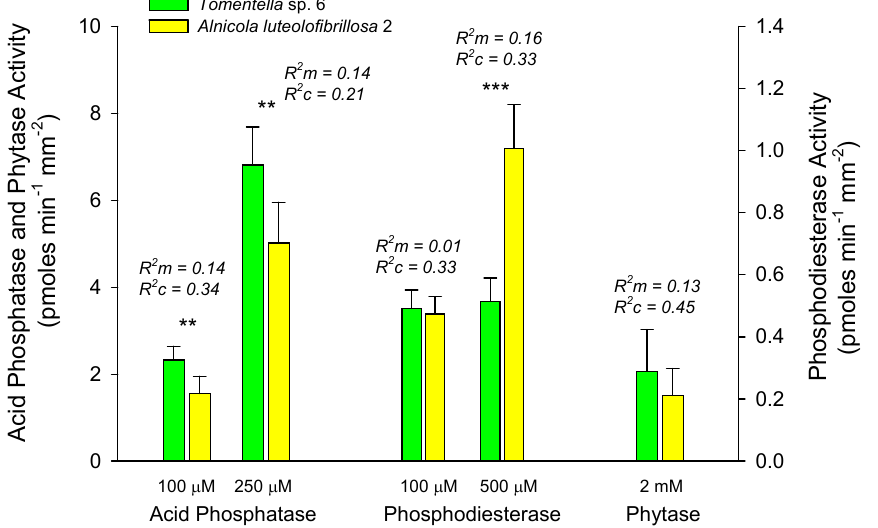
Figure 5. Comparison of mean ± S.E. activities of acid phosphatase, phosphodiesterase, and phytase of alder root tips dominated by Tomentella sp. 6 versus Alnicola luteolofibrillosa 2 averaged across horizons and stages. Significant differences between species are indicated above bars at p < 0.05 (**), and 0.01 (***). Marginal ( R 2 m ) and conditional ( R 2 c ) values generated for linear mixed effects models evaluate variance explained by fixed and fixed + random effects, respectively (see Statistics section above).